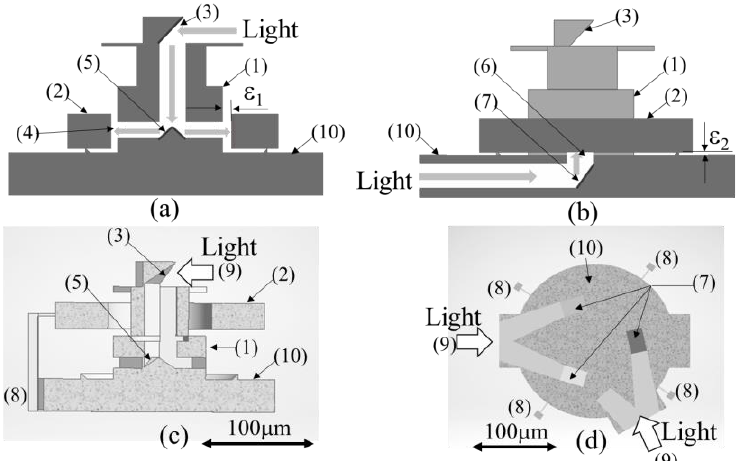
Figure 2. Three-dimensional structure of friction-reduction confirmation mechanism. (1) Shaft, (2) Rotating ring, (3) Mirror-1, (4) Aperture-1, (5) Mirror-2, (6) Aperture-2, (7) Mirror-3, (8) Support, (9) Entrance of light, (10) Base, ( a ) Light propagation in circumferential direction, ( b ) Light propagation in vertical direction, ( c ) Vertical cross-section of model, ( d ) Horizontal cross-section of model. A hand (4) is constructed in advance at point P0 on the circumference of the rotating